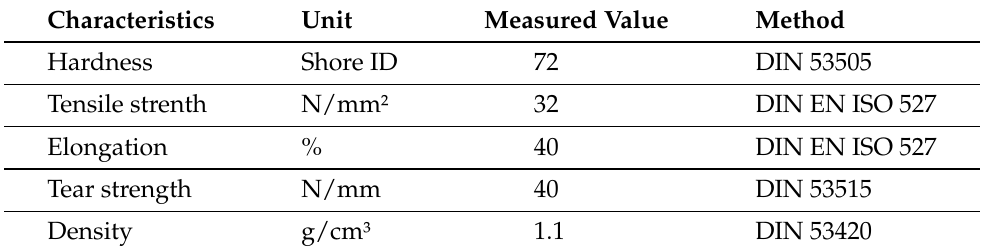
Table A2. Typical physical